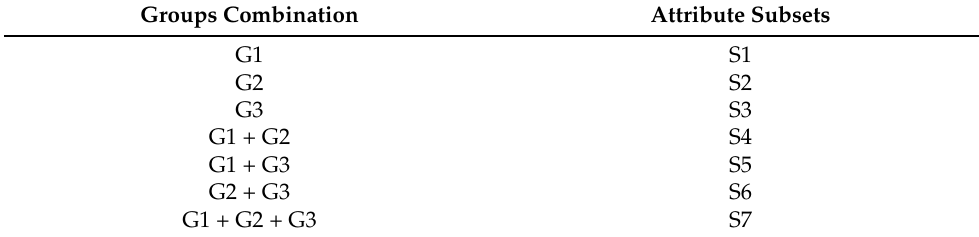
Table 2. Attribute